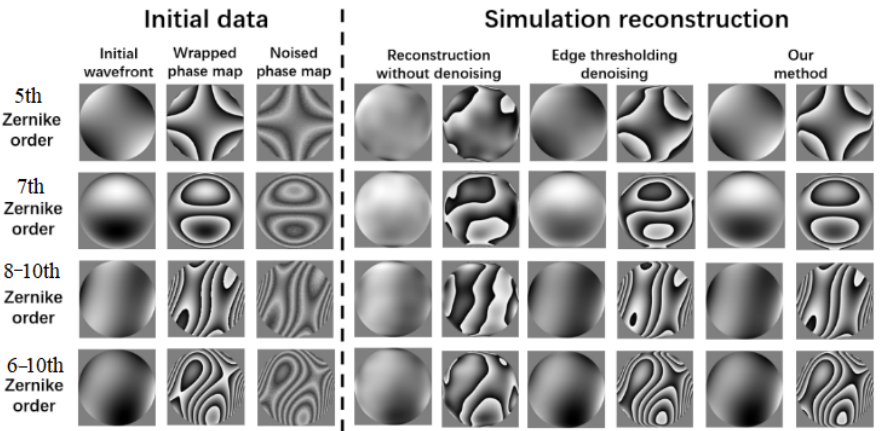
Table 3. MSE and Strehl ratio for each filtering method of Figure 10. Figure 11. The unwrapping results of noised Zernike aberrations on initial and simulated data.